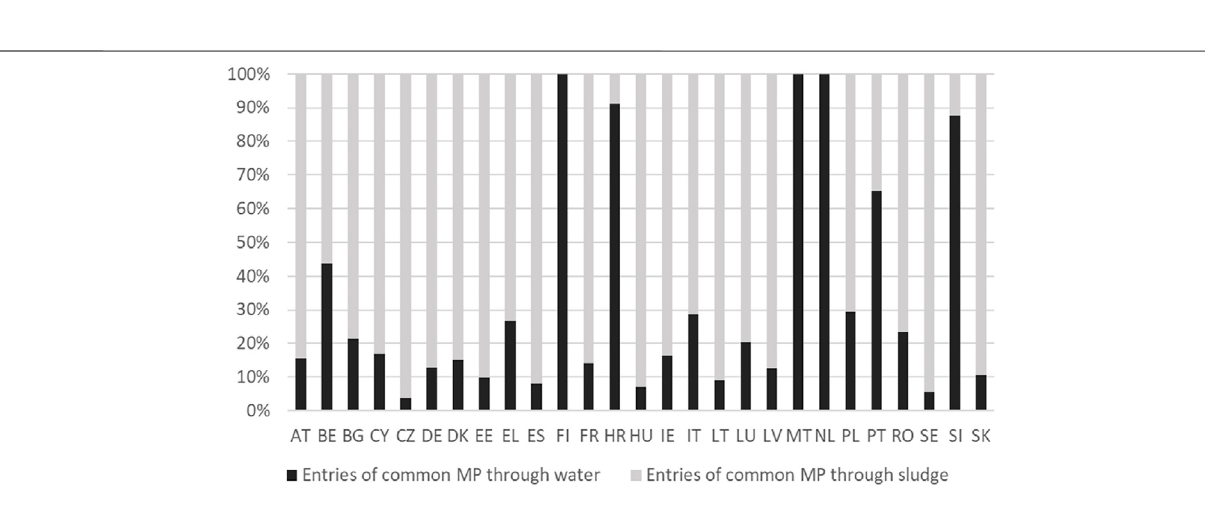
Frontiers in Environmental Science |